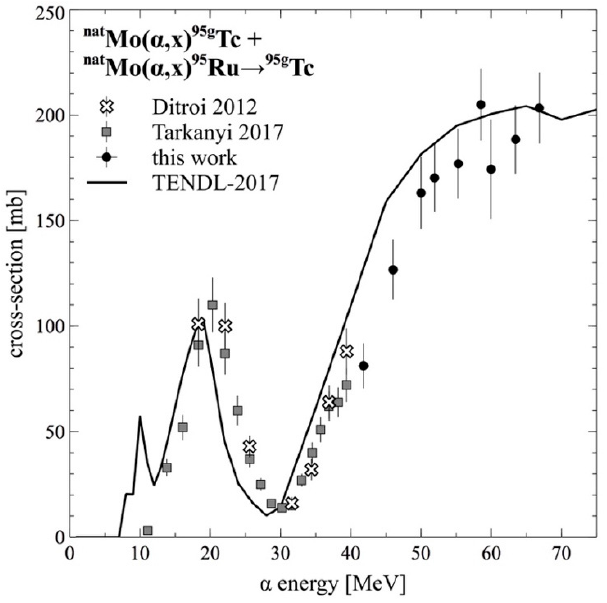
Figure 4. Measured cross-section for nat Mo( ⍺ ,x) 95g Tc reaction compared with the literature.